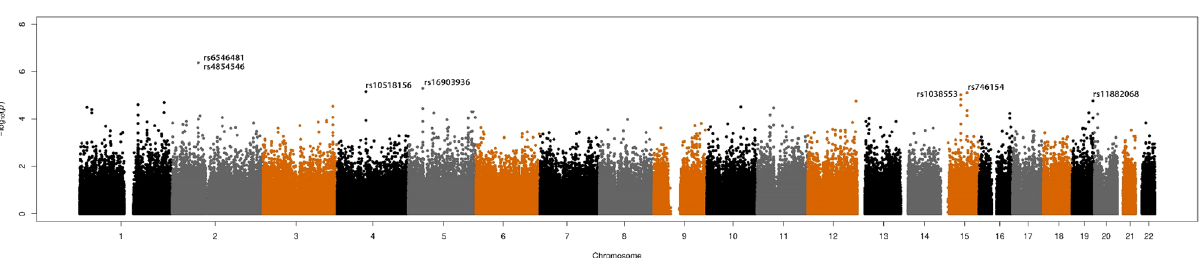
Figure 2. Manhattan plots of the genome-wide association analysis with moderate to severe xerostomia among oropharyngeal cancer survivors. The y -axis represents the − log 10 P